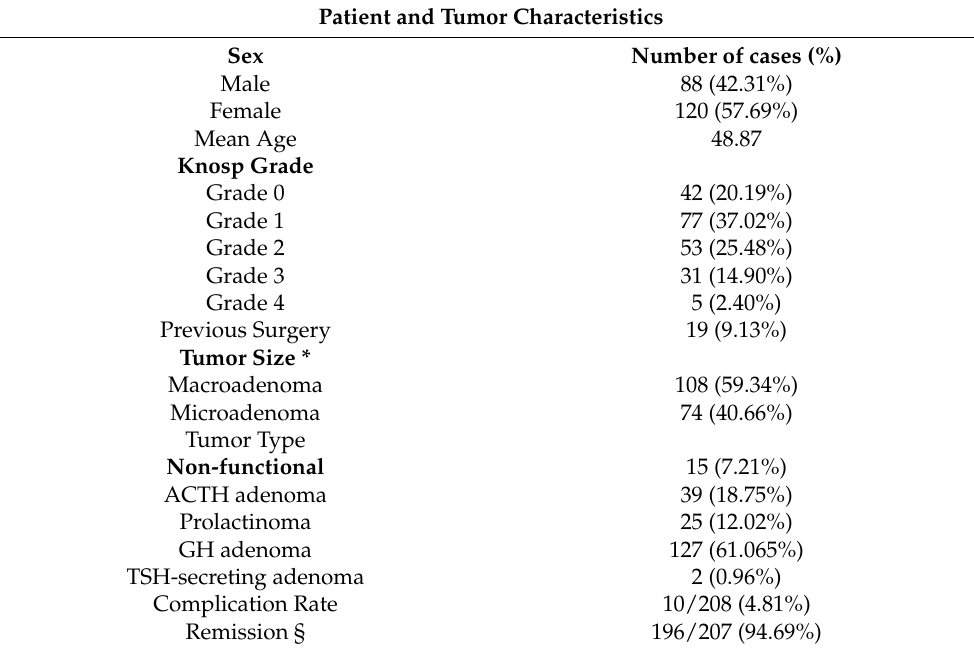
Table 1. Patient cohort summary of the 5 selected studies included in this analysis. Variables include sex, mean age, Knosp grade, previous surgery, tumor size, tumor type, complication rate, and